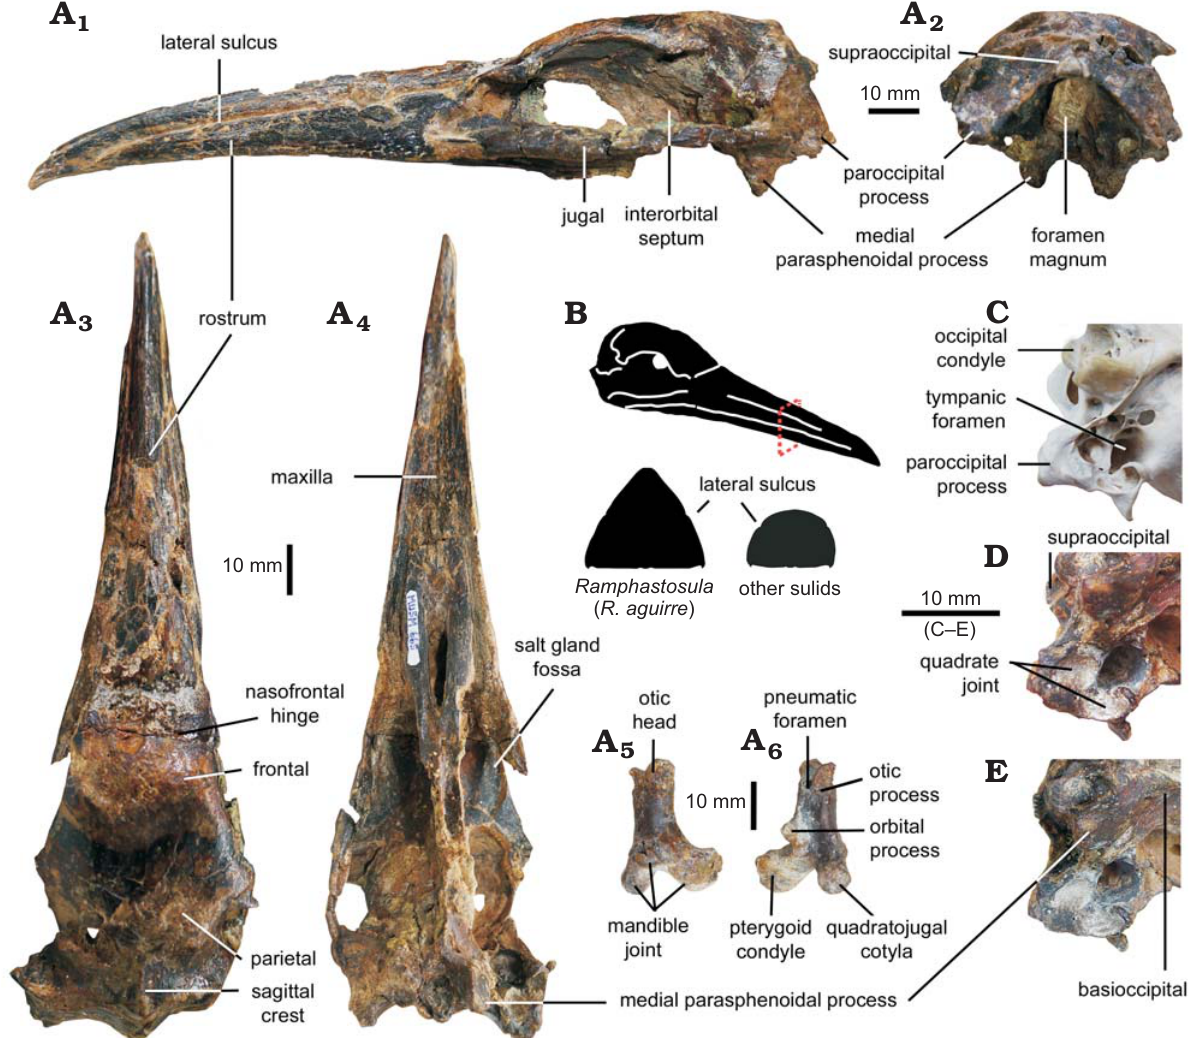
Fig. 4. Sulid bird Ramphastosula aguirrei sp. nov. from Poza Negra, Sacaco Sur (Peru), Pisco Formation, Late Miocene. A Holotype MUSM 665. Skull in lateral (A 1 ), posterior (A 2 ), dorsal (A 3 ), and ventral (A 4 ) views. Left quadrate in (A 5 ) anterior and (A 6 ) posterior views. B . Section of rostrum at its mid- length showing differences in the outline of Ramphastosula and other sulids. C – E . Comparison of the ear region in ventral view in the Peruvian booby Sula variegata DPV AM P8 ( C ) from Isla Lobos de Afuera, Lambayaque (Peru), Recent; R. ramirezi MUSM 264 ( D ) from Poza Roja , Sacaco Sur (Peru), Messinian (Late Miocene); and R. aguirrei MUSM 665 ( E ) from Poza Negra, Sacaco Sur (Peru), Messinian (Late